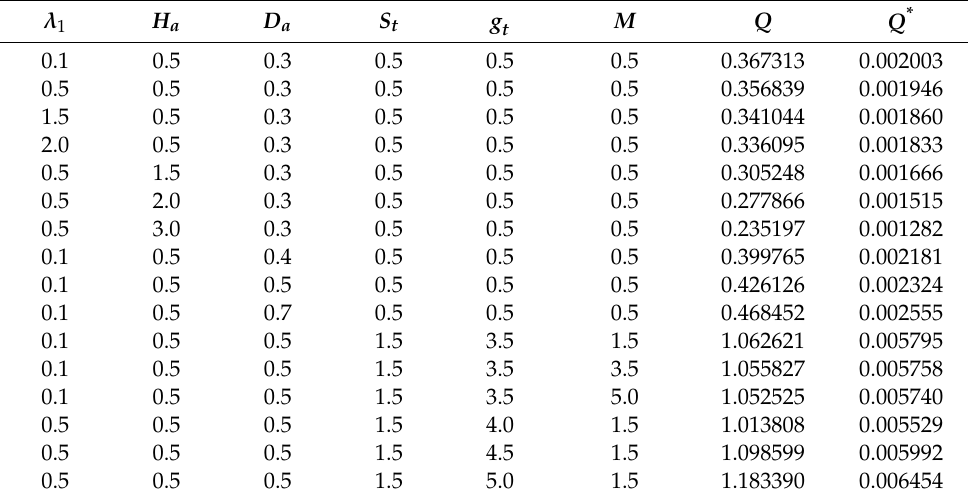
Table 1. Numerical results for the dimensional flow rate Q and non-dimensional flow rate Q ∗